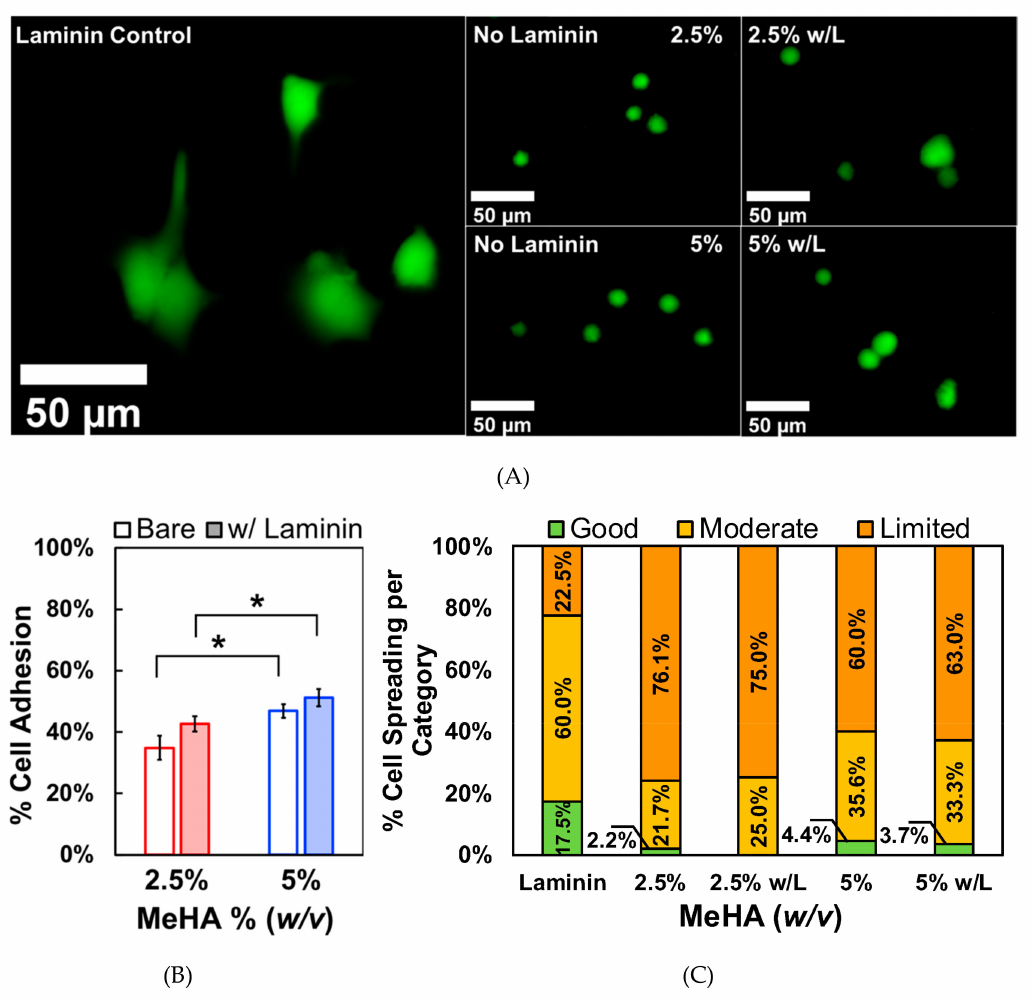
Figure 4. Comparison study of ReNcell VM adhesion on crosslinked x-MeHA hydrogel versus laminin-coated polystyrene. ( A ) Representative fluorescence microscopy images of cell spreading are presented. Far left laminin coating is on tissue culture plastic while the right 2 × 2 images all involve crosslinked x-MeHA hydrogels. ( B ) Significantly less cells were able to adhere to the hydrogel surfaces regardless of surface coating. Surface coating the hydrogels with laminin (w / L) improved adhesion but not significantly. In both conditions, the 5% w / v hydrogels promoted significantly, improved cell adhesion compared to 2.5% w / v hydrogels (* p < 0.05). Error bars are depicted as standard error. ( C